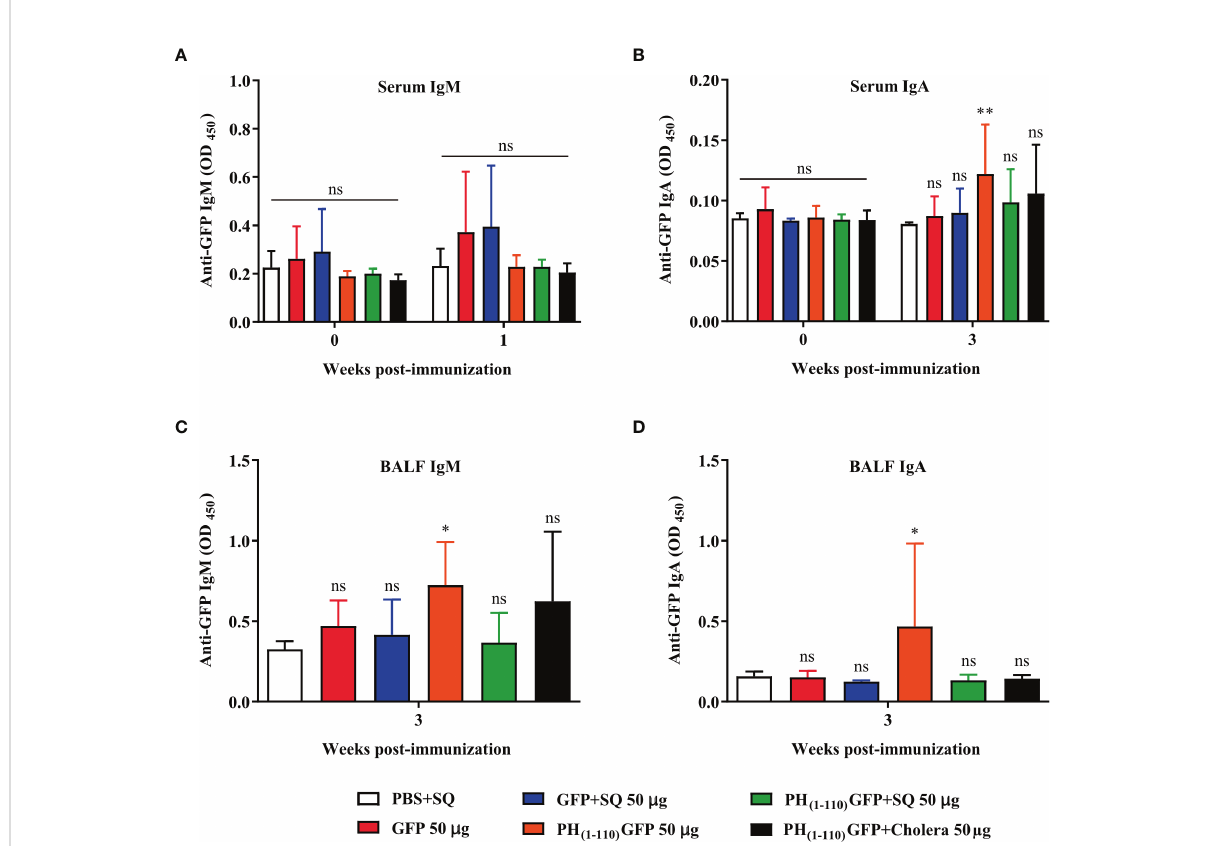
FIGURE 7 The presence of IgM and IgA in BALF and serum demonstrate the induction of systemic and local responses by PH (1-110) GFP NPs. (A) Evaluation of the presence of IgM in serum. IgM was evaluated in the fi rst week post-immunization because it is an immunoglobulin that is produced in the fi rst days of the immune response. (B) The presence of serum IgA was assessed at week 3 post-immunization when response to all 3 doses of treatments was established. The procedure to obtain Bronchoalveolar Lavage Fluid (BALF) from mice requires euthanasia, for this reason only the presence of IgM (C) and IgA (D) was evaluated at week 3 post-immunization. The determination of IgM and IgA immunoglobulins was performed by ELISA assay. Data represent the mean ± SD (For PH (1-110) GFP +cholera, n = 6; for the other groups, n = 7). All groups were compared against the PBS+SQ group. The p values were determined by Two-way ANOVA with Dunette post-tests. * p < 0.033; ** p < 0.002; ns = not signi fi